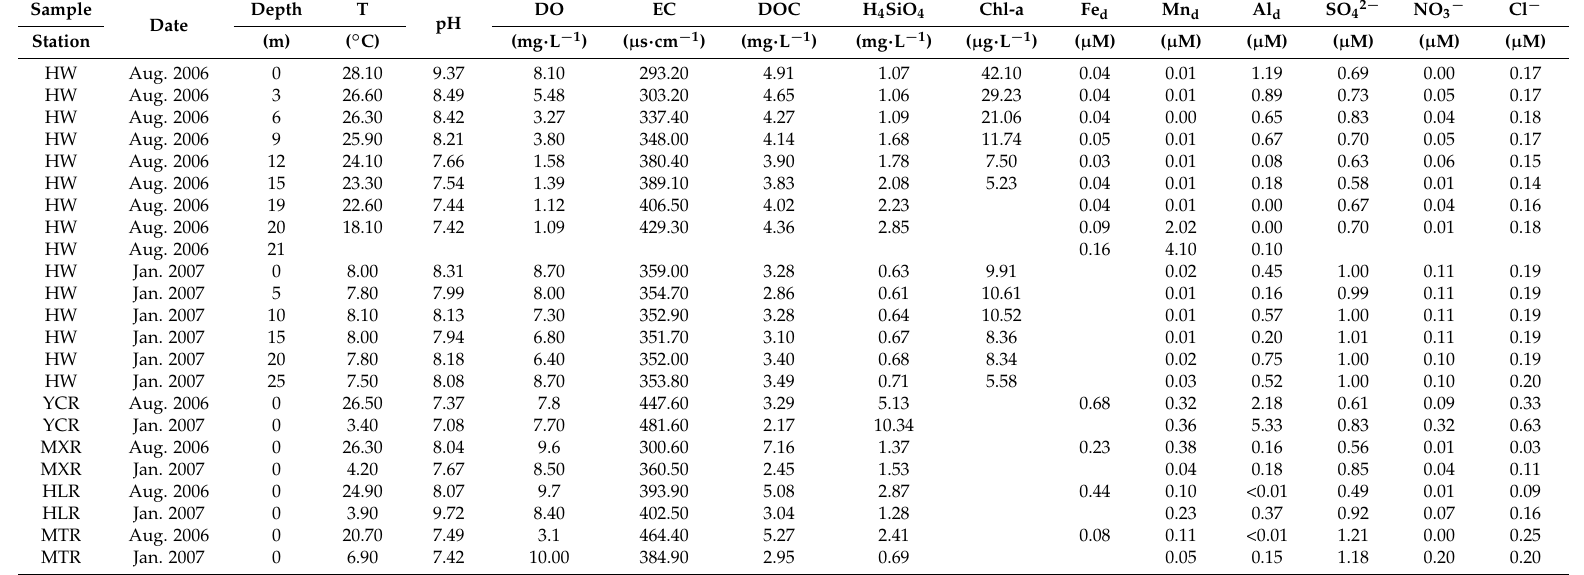
Table 2. Environmental parameters and chemical data for Hongfeng Lake and its